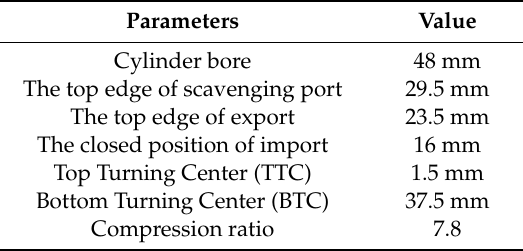
Figure 3. Structure of the combustion system. Table 1. Combustion system of the FPEG.